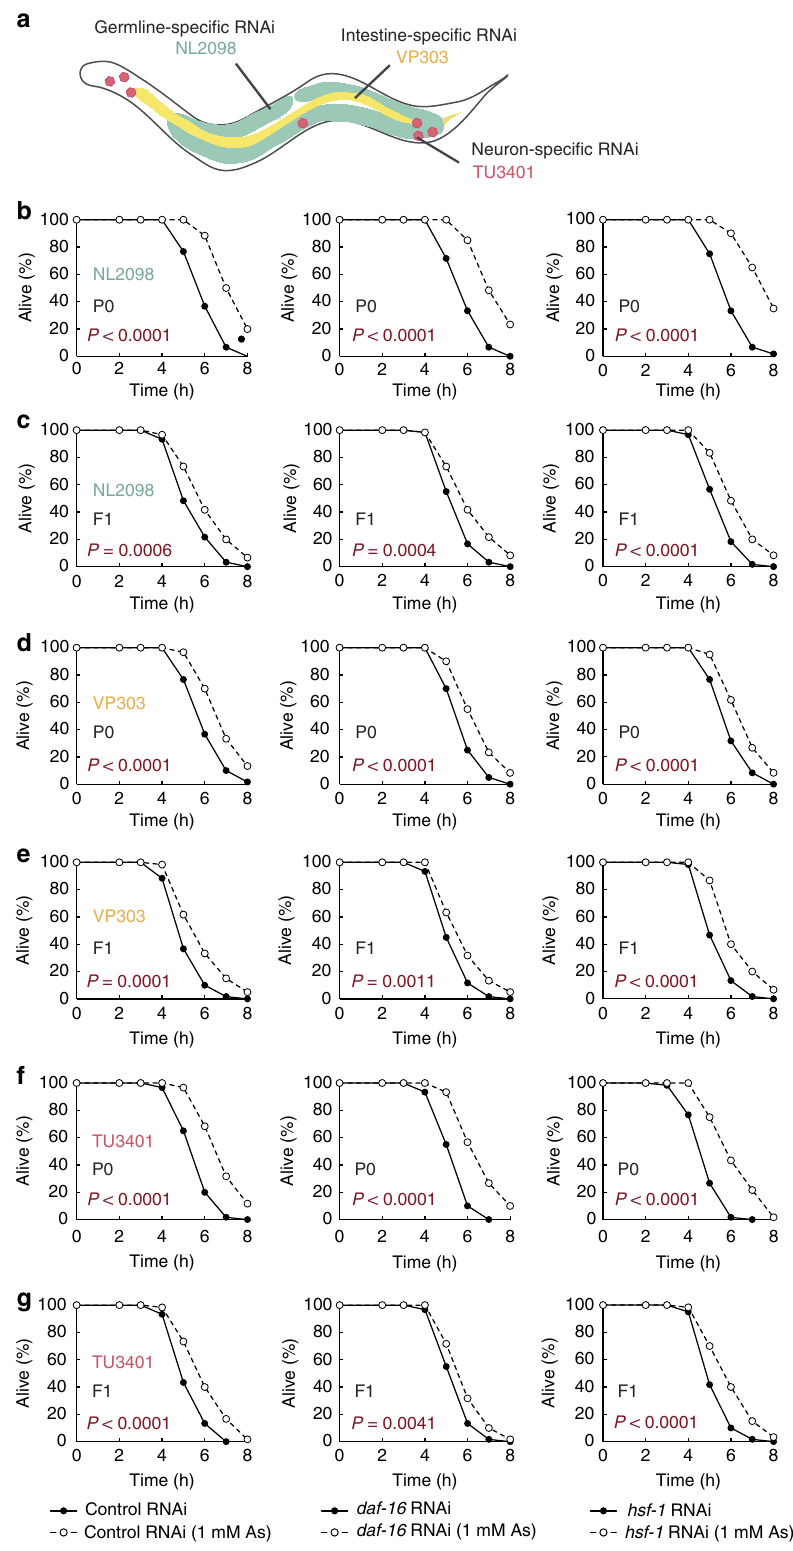
Figure 5 | Tissue-specific RNAi of daf-16 or hsf-1 . ( a ) Strains used for the tissue-specific gene knockdown. ( b , c ) Oxidative stress resistance (2mM H 2 O 2 ) of the stressed P0 parents treated with germline-specific RNAi (left, empty vector (control); middle, daf-16 ; right, hsf-1 ) on day 2 adulthood ( b ) and the self-fertilized F1 descendants on day 1 adulthood ( c ). ( d , e ) Oxidative stress resistance (2mM H 2 O 2 ) of the stressed P0 parents treated with intestine-specific RNAi on day 2 adulthood ( d ) and the self-fertilized F1 descendants on day 1 adulthood ( e ). ( f , g ) Oxidative stress resistance (2mM H 2 O 2 ) of the stressed P0 parents treated with neuron-specific RNAi on day 2 adulthood ( f ) and the self-fertilized F1 descendants on day 1 adulthood ( g ). Two independent experiments are integrated into each survival curve ( n ¼ 60). P values were calculated by log-rank